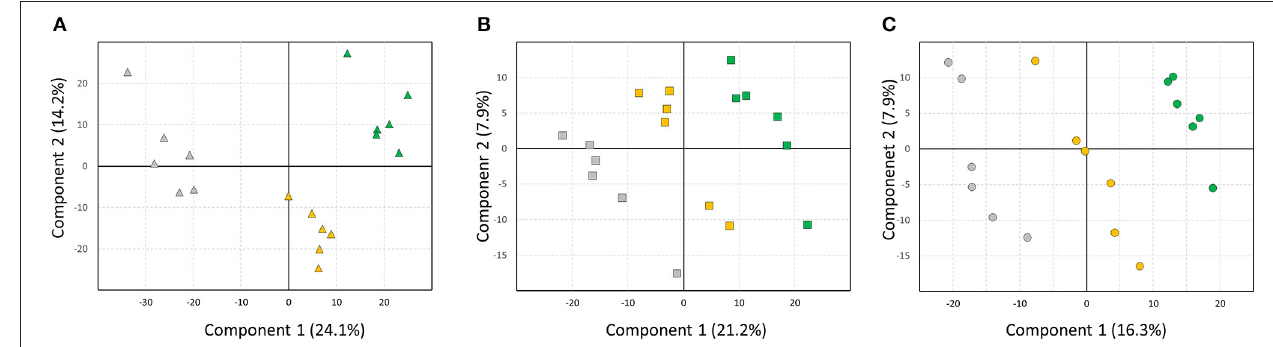
FIGURE 10 | Partial least squares discriminant analysis (PLS-DA) based on methyl jasmonate-mediated changes in leaf secondary metabolites in strawberry plants in different developmental stages. (A) 9-week-old leaf metabolomes; (B) 15-weeks old; (C) 24-weeks. Gray symbols: mock-treated control plants; green symbols: MeJA-treated every 3 weeks; yellow symbols: MeJA treatment upon scouting. Cross-validation of the models: Q 2 = 0.8, 0.75, and 0.75, respectively.